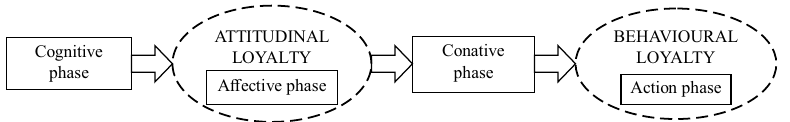
Fig. 1. The place of loyalty dimensions in the cycle of loyalty